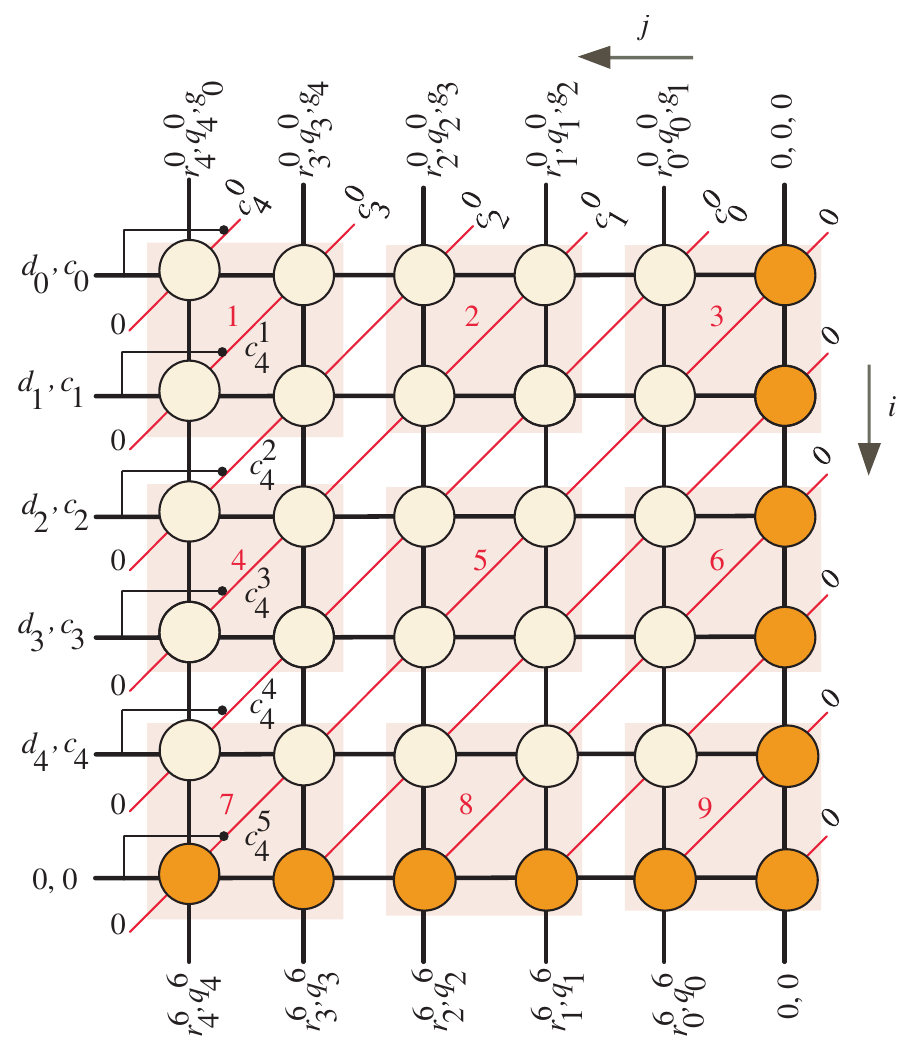
Figure 2. Scheduling time for the case when m = 5 and w = 2. Notice that we added an extra column on the right and extra row at the bottom to render the number of columns and rows integer multiples of w . In general, we should add µ extra columns and µ extra rows to render the number of columns and rows an integer (cid:6) m (cid:7) − m . multiple of w , where µ = w w Figure 3 shows the node timing (scheduling time) for the case when m = 5, and w = 4. In this case µ = 3, thus we had to add three extra columns on the right and three extra rows at the bottom to render the number of columns and rows an integer multiple of w . Therefore, the LSBs of inputs C and G and LSBs of the initial values of intermediate variables R and Q should be padded by µ zeros on the right as shown in Figure 3. Furthermore, the MSBs of inputs D and C should be padded by µ zeros at the bottom, as shown in the same figure. The equitemporal zones are shown as light red boxes with the associated time index values indicated in red numerals within each zone. Notice that the bits of c i − 1 are com- m − 1 puted at the nodes of column m − 2, as shown in Figure 3 and broadcasted horizontally along with the bits of d i − 1 and c i − 1 to the nodes of row i − 1. One last detail needs to be mentioned here and is best explained with reference to two adjacent equitemproal zones executing at times n and n + 1. Figure 4 illustrates this